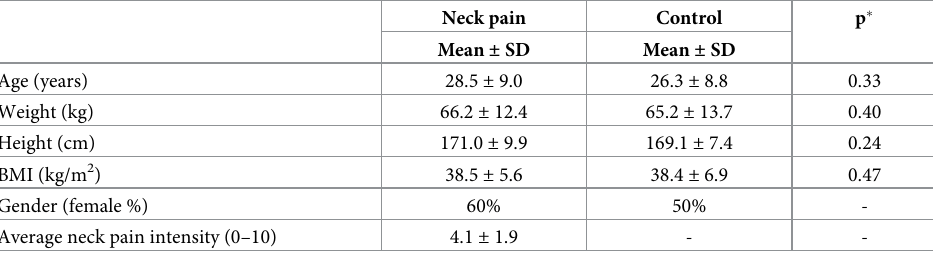
Table 2. Demographic characteristics of